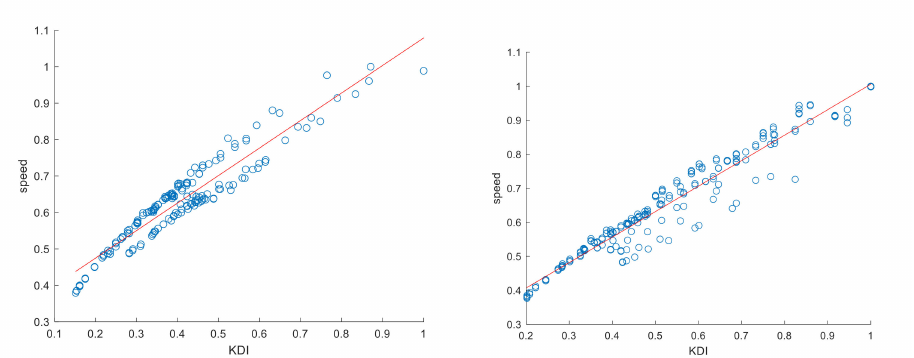
Figure 10. Scatter diagram of the KDI versus speeds for the SCARA ( left ) and articulated ( right )